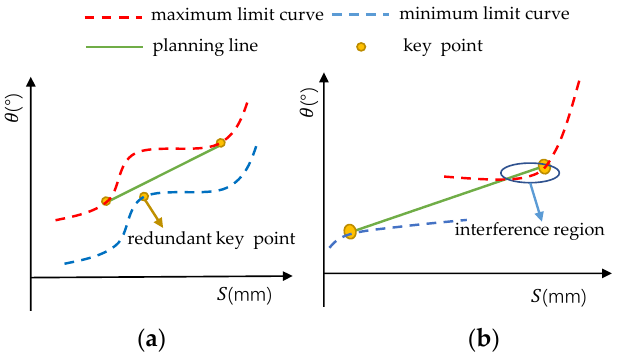
Figure 7. Two situations where key points need to be adjusted. ( a ) Redundant key point; ( b ) beyond feasible region.